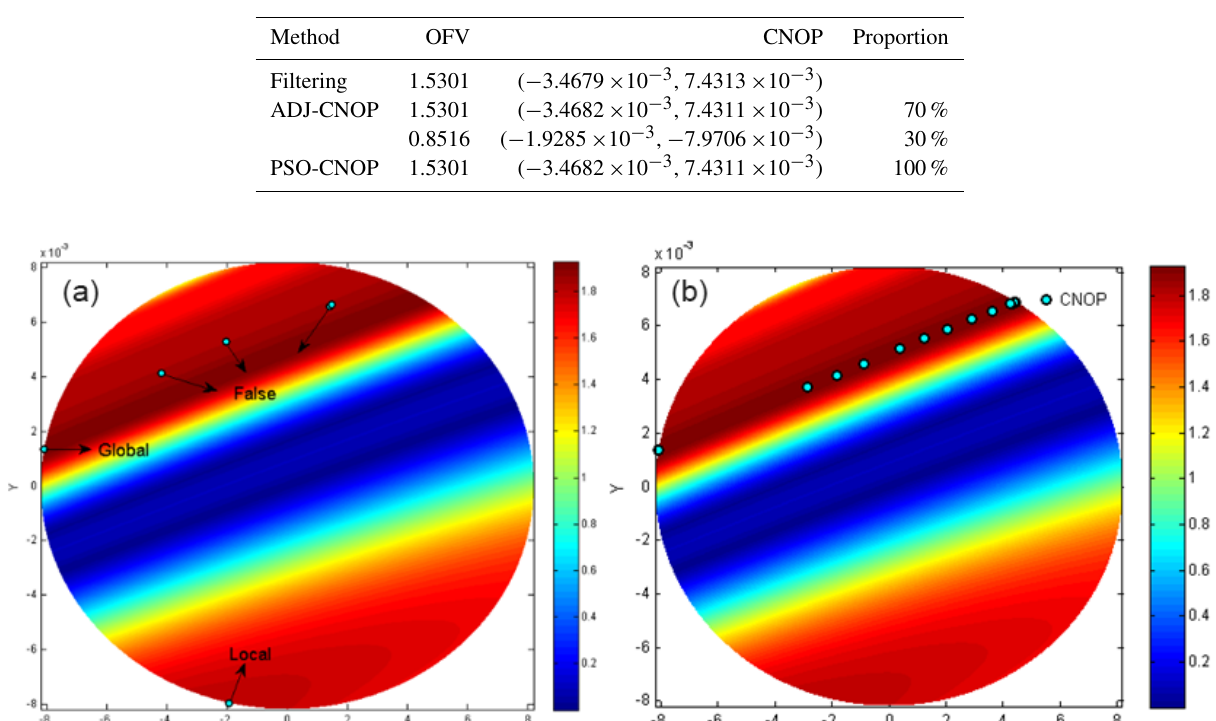
Figure 5. The distributions of OFVs at the prediction time 14 (cid:49)t , where the dots in the left (right) panel are the CNOPs produced by ADJ-CNOP (PSO-CNOP).